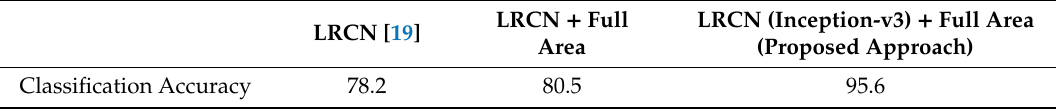
Table 5. Comparison results of classification